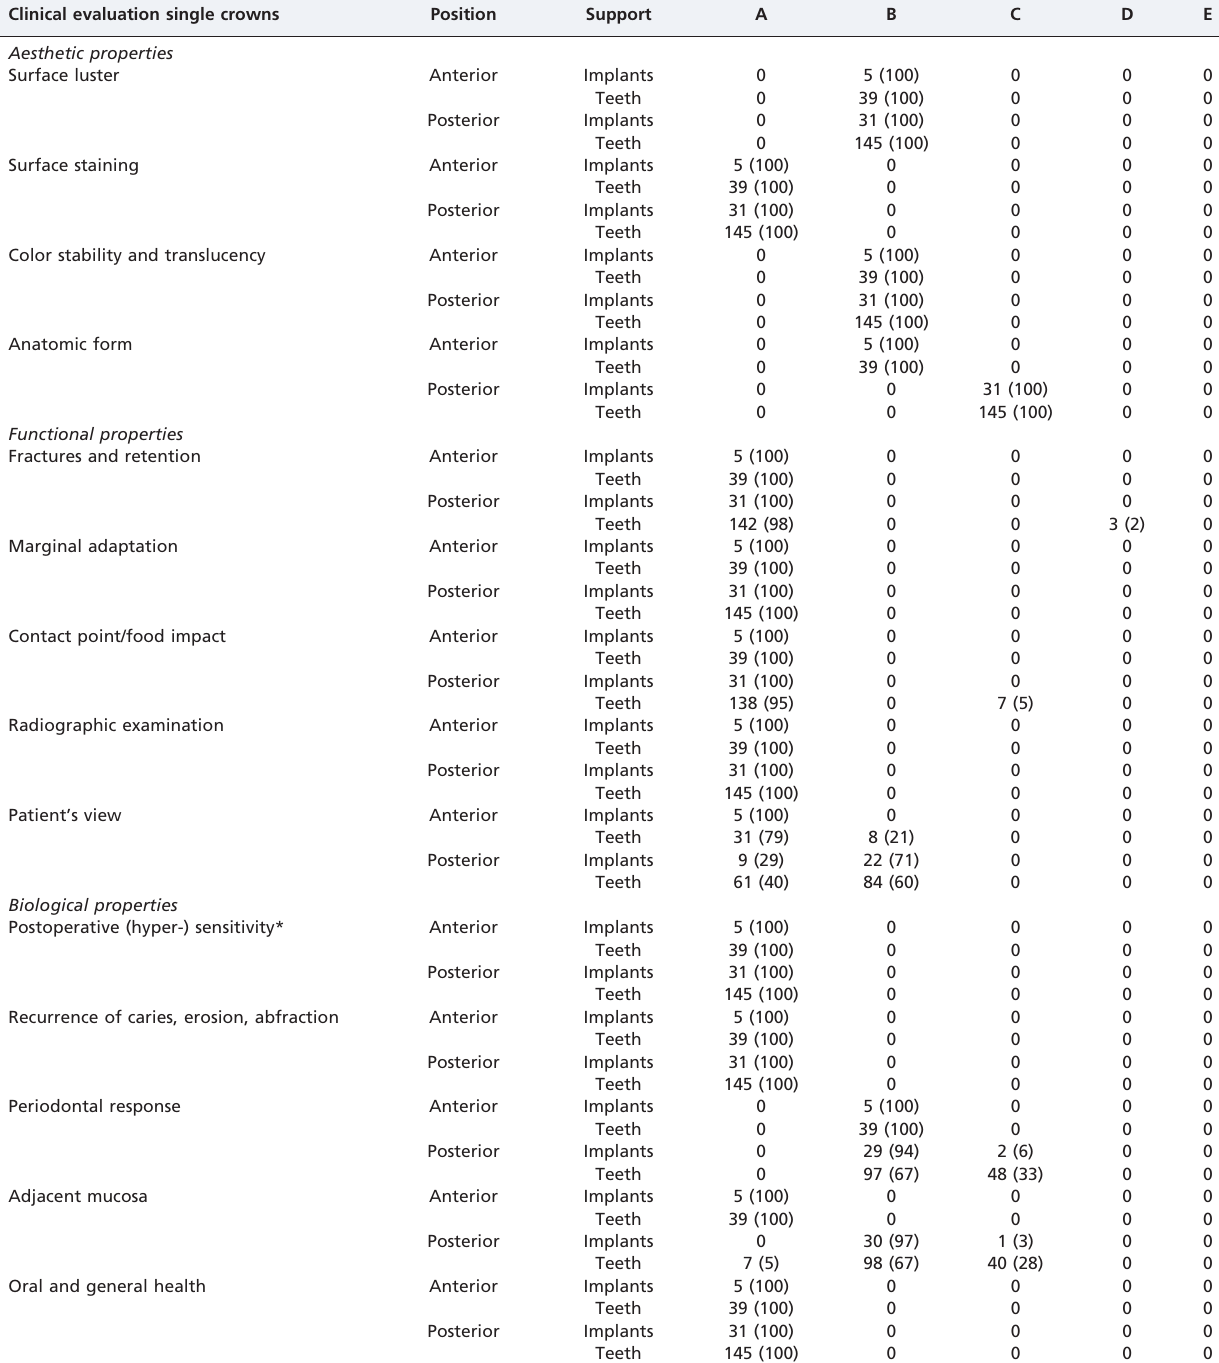
Table 3 - Clinical evaluation of the analyzed single-crown zirconia prostheses, according to Hickel et al. 22 at the three- year follow-up examination. All values represent the number (and percentage) of